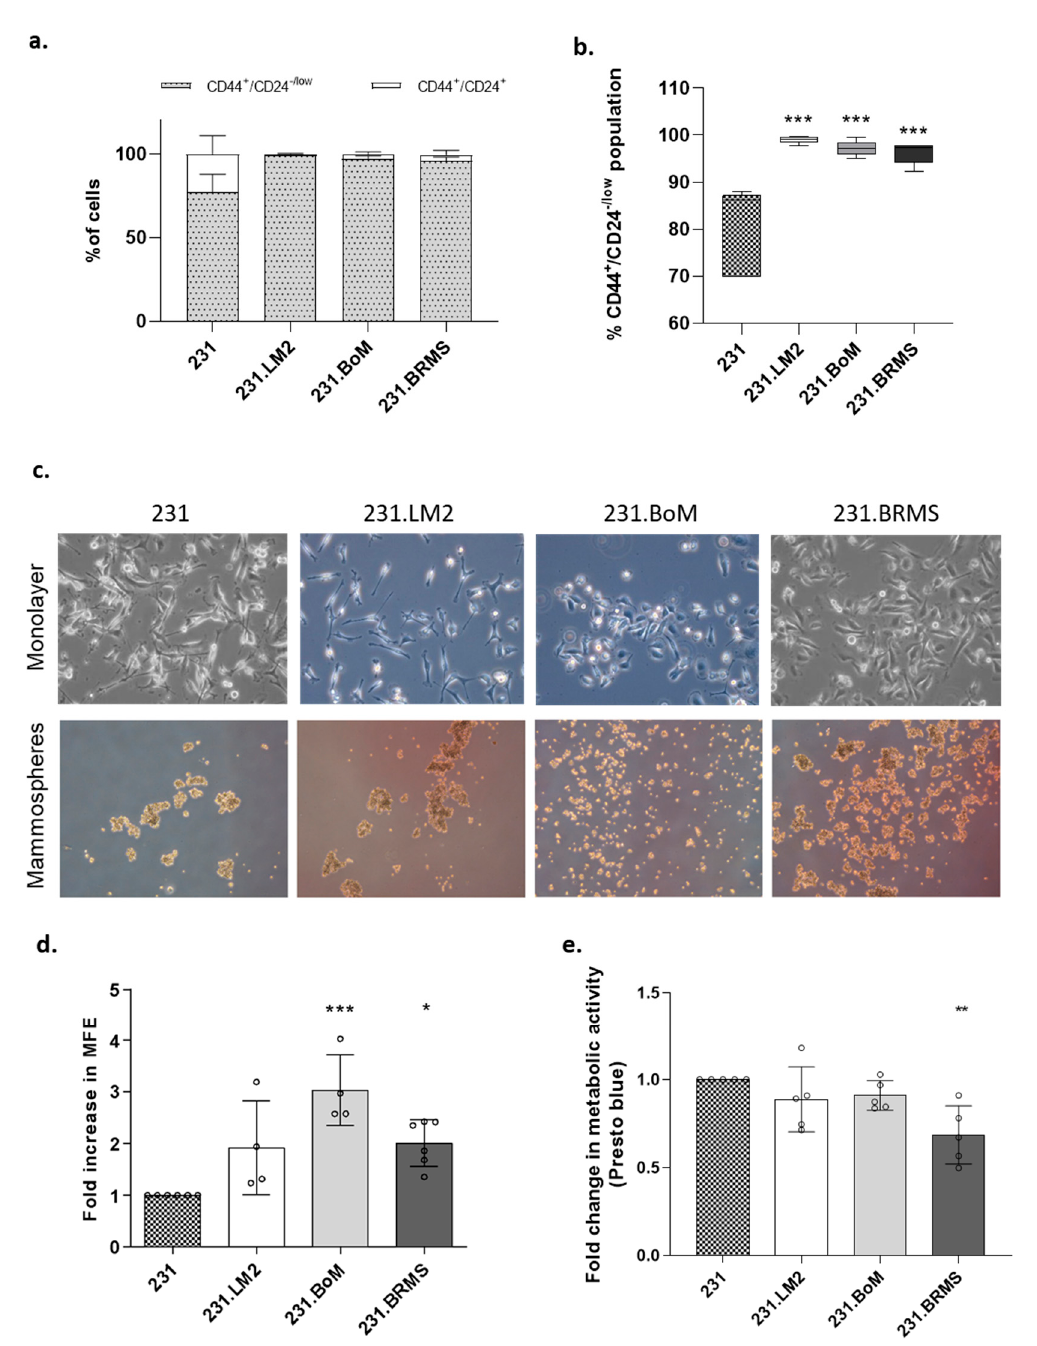
Figure 2. Organotropic breast cancer cells show increased in vitro cancer stem cell (CSC) properties. ( a ) Characterization of the cancer cell populations for CD44 and CD24 CSC markers by flow cytometry analysis in 231 breast cancer cells and its organotropic variants. ( b ) Percentage of the CSC population CD44 + /CD24 − /low in 231 breast cancer cells and its organotropic variants. ( c ) Representative picture of monolayer (2D) and mammospheres (20 × magnification). ( d ) Mammosphere-forming efficiency (MFE) in organotropic breast cancer cells (minimum of 4 biological replicates) compared with parental cells. ( e ) Fold change in cell viability and metabolic activity measured by the Presto blue assay. Five biological replicates; *— p < 0.05, **— p < 0.01 and ***— p < 0.001.